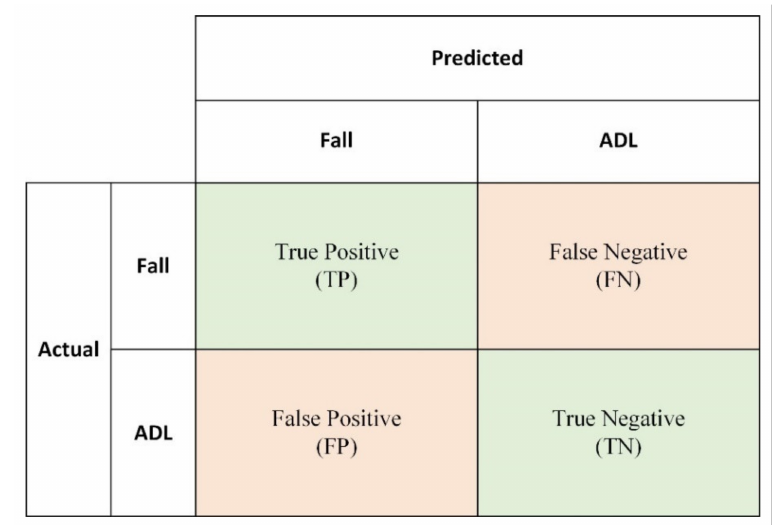
Figure 7. The confusion matrix of fall